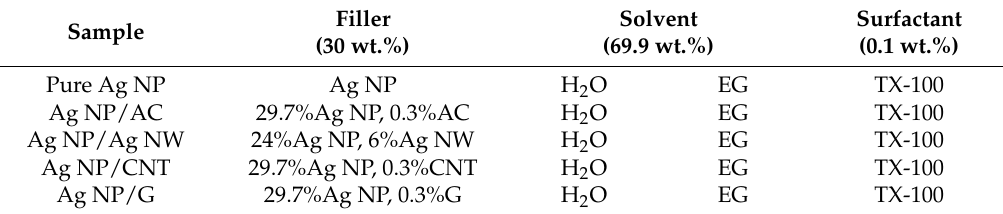
Table 2. Contents of composite